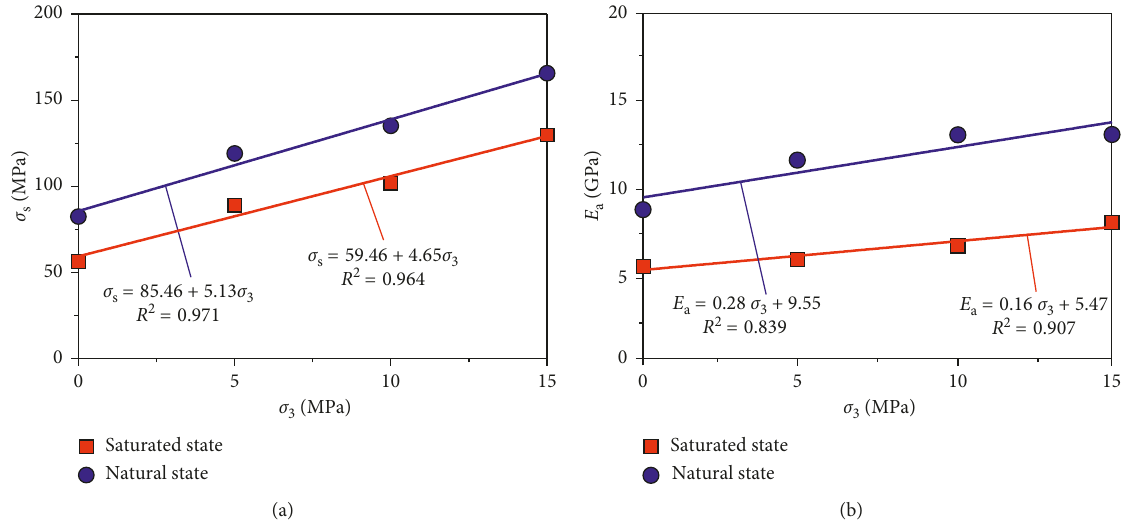
Figure 3: Effect of confining pressure on the (a) triaxial compression strength and (b) elasticity modulus of the argillaceous limestone specimens in the saturated and natural states, respectively.